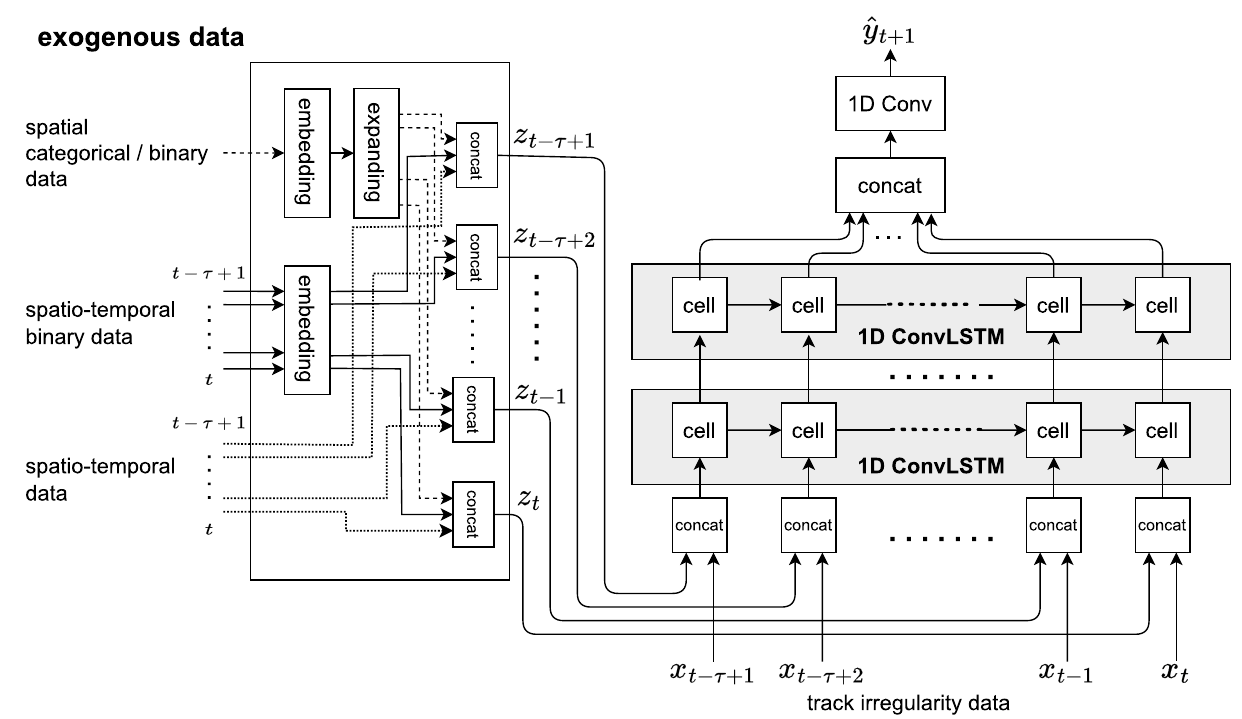
Figure 2. ConvLSTM with exogenous data, i.e., the proposed model that predicts vertical alignment. The left part is the exogenous embedding part. The right part is the ConvLSTM